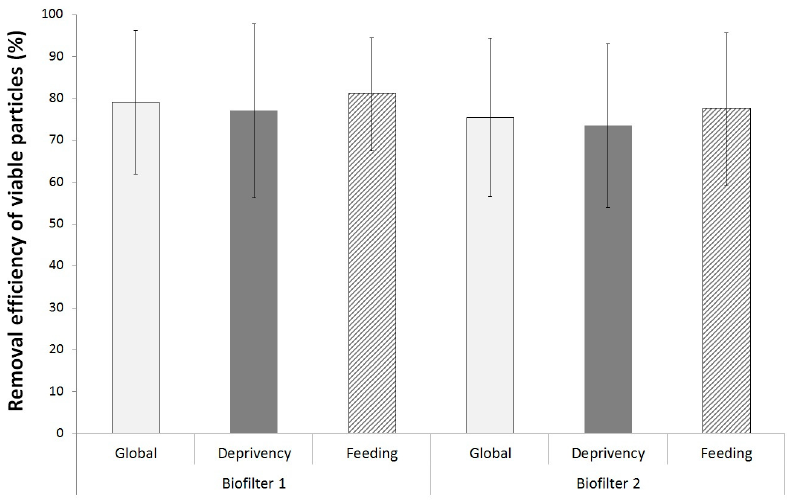
Figure 2. RE vp for both biofilters during the pollutant alternation of deprivency and feeding periods ( n deprivency = 25/bars, n feeding = 27/bars).